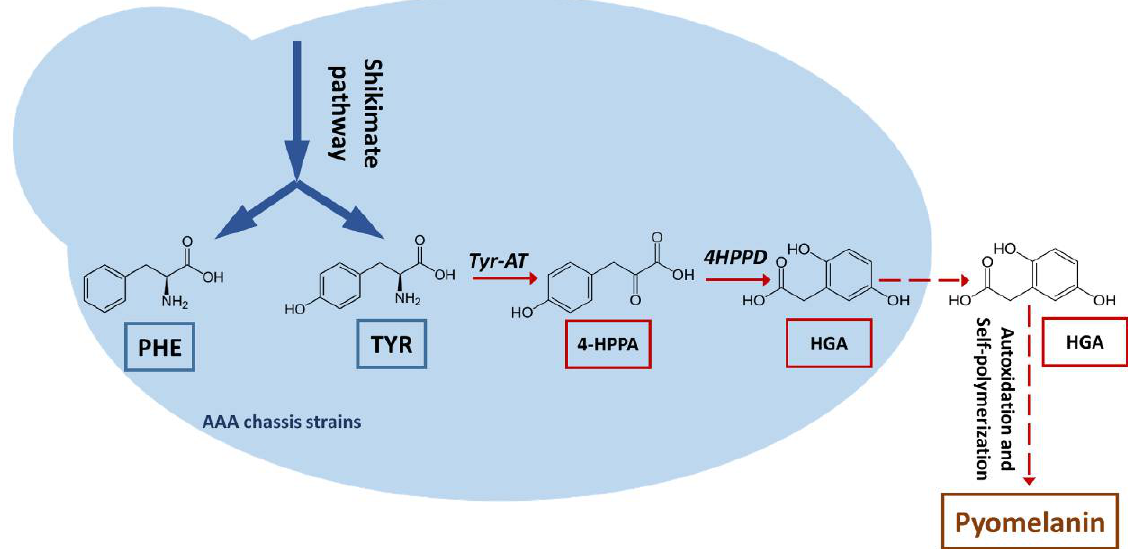
Figure 1. Schematic representation of the pyomelanin biosynthesis pathway. PHE: phenylalanine; TYR: tyrosine; Tyr-AT : tyrosine aminotransferase; 4-HPPA: 4-hydroxyphenylpyruvic acid, 4HPPD : 4-hydroxyphenylpyruvic acid dioxygenase; HGA: homogentisic acid.